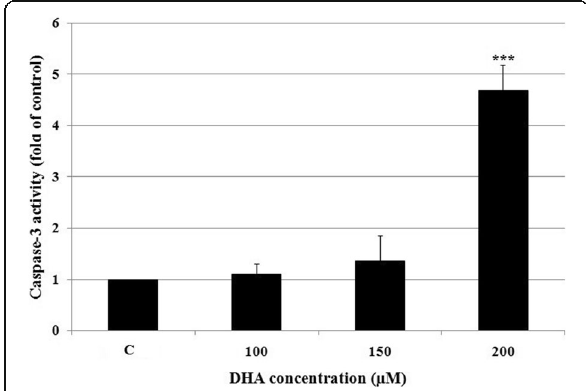
Fig. 6 Effect of DHA on caspase-3 activation. 5×10 5 HCT-116 cells were treated with various concentrations of DHA for 48 h after which caspase-3 activity was measured in tumor cell lysates using colorimetric assay. All experiments were repeated twice using triplicate assays and results were presented as mean±SD. *** P <0.001 vs. untreated control cells